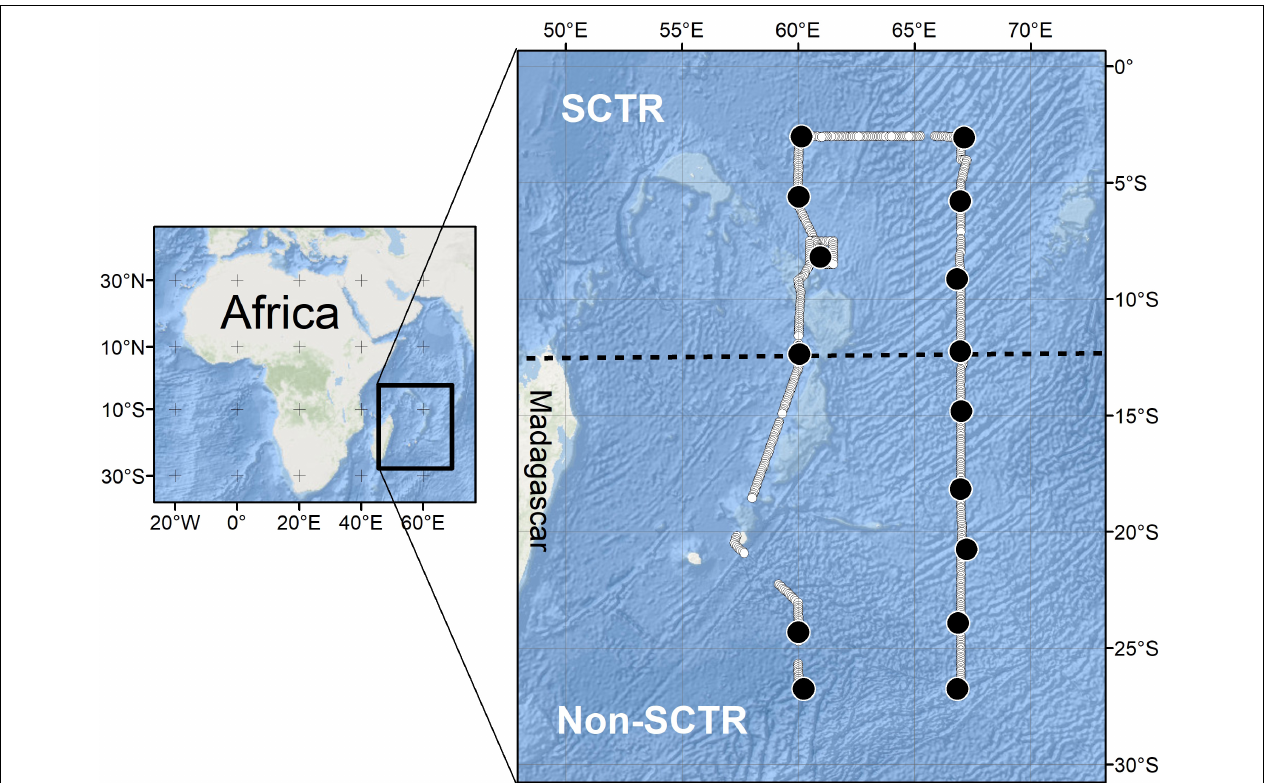
FIGURE 1 | The study area. The line composed of white closed circles is the voyage track. The region north of 12 ◦ S is defined as Seychelles-Chagos Thermocline Ridge (SCTR) and that south of 12 ◦ S is called as non-SCTR. The black dot indicates the station of MOCNESS. The location of the CTD station is not displayed but is every degree of latitude between 3 ◦ S and 27 ◦ S at 60 ◦ E and 67 ◦ E longitude, respectively.